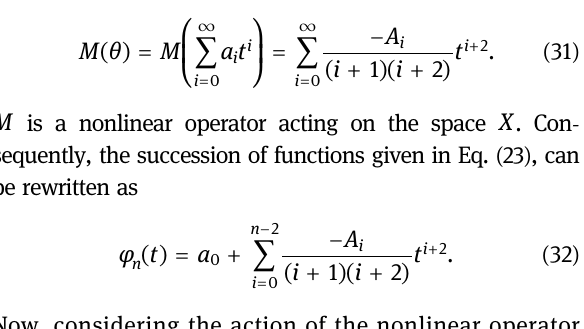
20 ⟨ ⟩ with step - size k